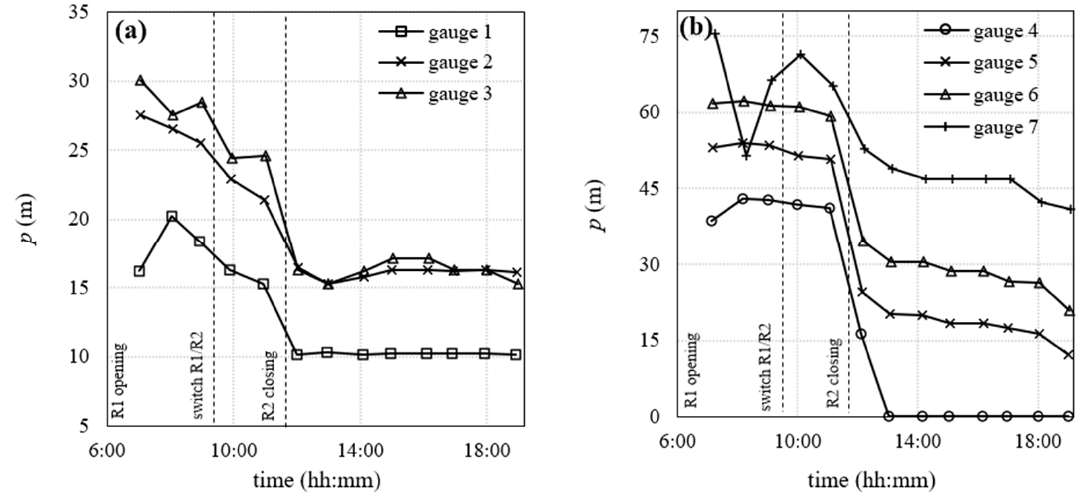
Figure 4. Nodal pressures p at nodes located in the ( a ) high, and ( b ) low zone of the WDN during the experiment of Sunday, 16 June 2019.